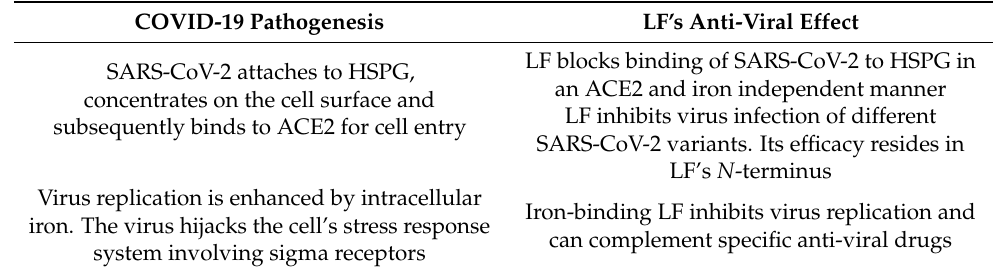
Table 2. Physiological effects as part of COVID-19 pathogenesis (left column) and corresponding anti-viral effects of LF (right